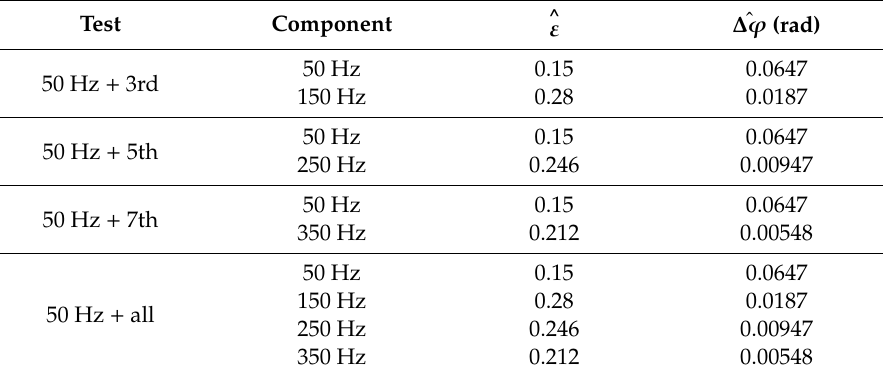
Figure 10. Synthesized distorted input signal and the measured signal prediction by simulation. ( a ) prediction for 1st + 3rd harmonics; ( b ) prediction for 1st + 5th harmonics; ( c ) prediction for 1st + 7th harmonics; ( d ) prediction for 1st + 3rd + 5th + 7th harmonics. Table 6. DW prediction results.